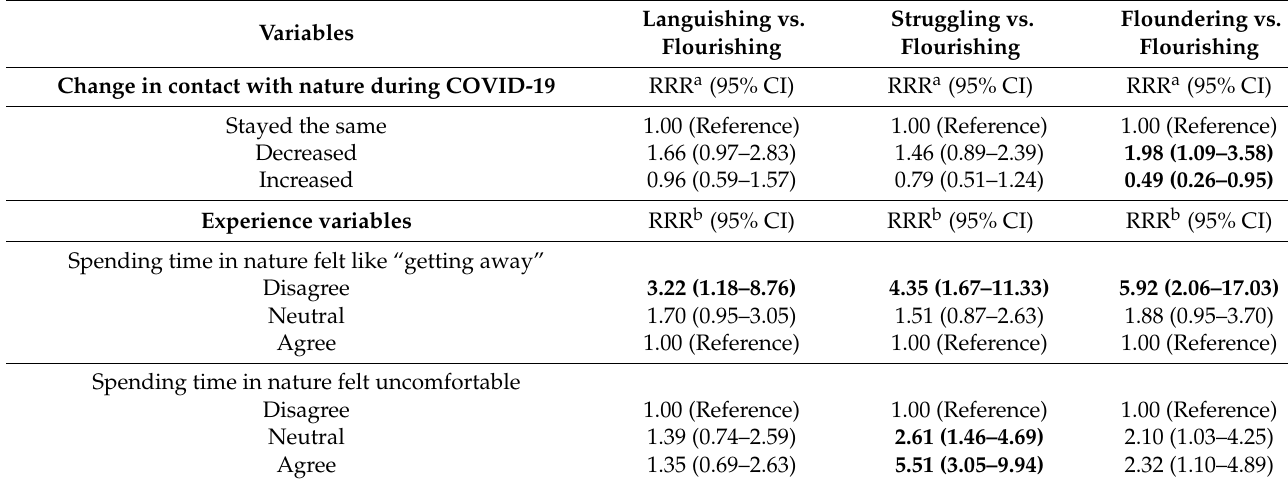
Table 6. Associations between purposive nature contact/experiences and mental health state during COVID-19 lock- downs/restrictions. Languishing vs. Floundering vs.